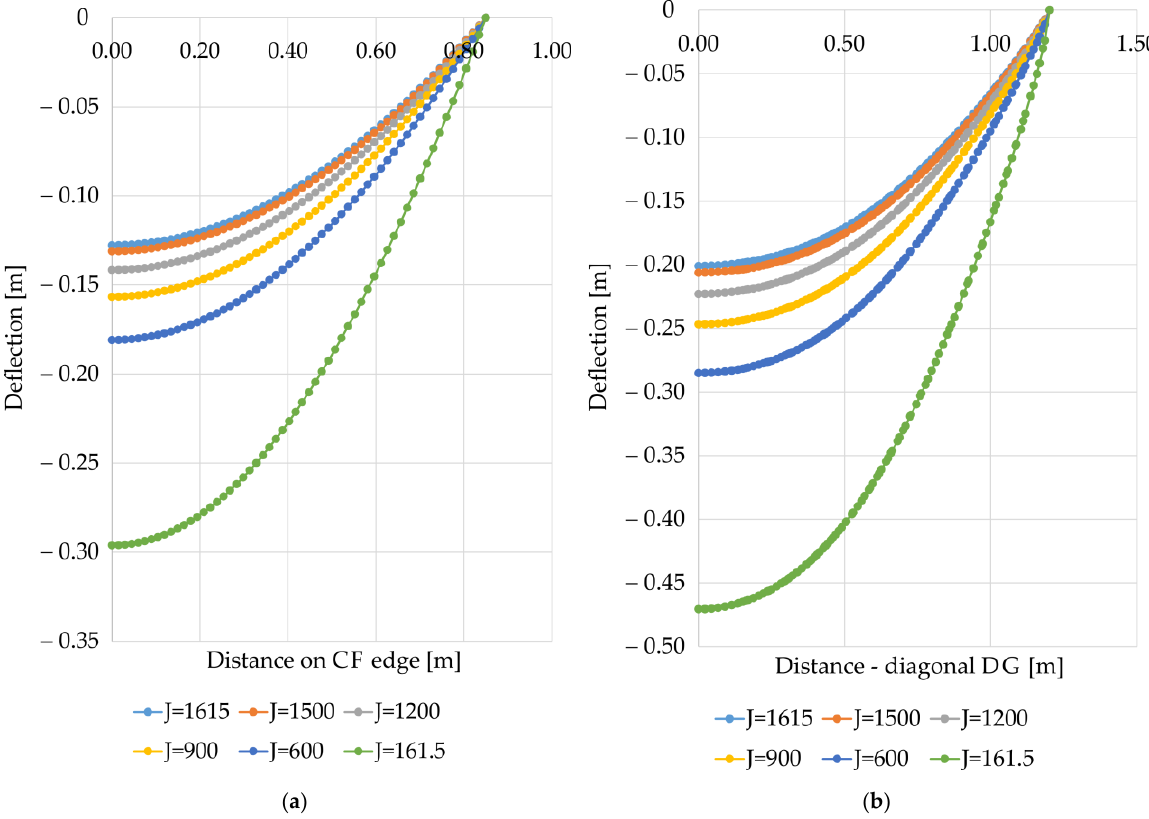
Figure 12. Deflection of the membrane modeling reinforcement for the variant A1 depending on the stiffness of the reinforcement: ( a ) on the edge CF (between columns); ( b ) on the diagonal DG.